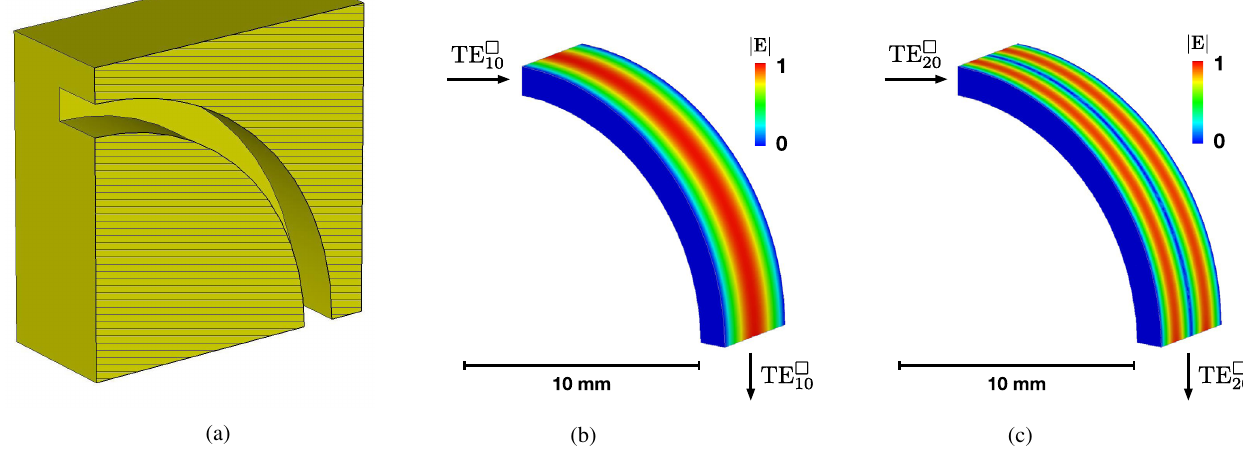
FIG. 19. TE □ 10 = TE □ 20 bend. (a) Metallic surface, (b) surface electric field for the TE □ 10 , and (c) Surface electric field for the TE □ 20 .